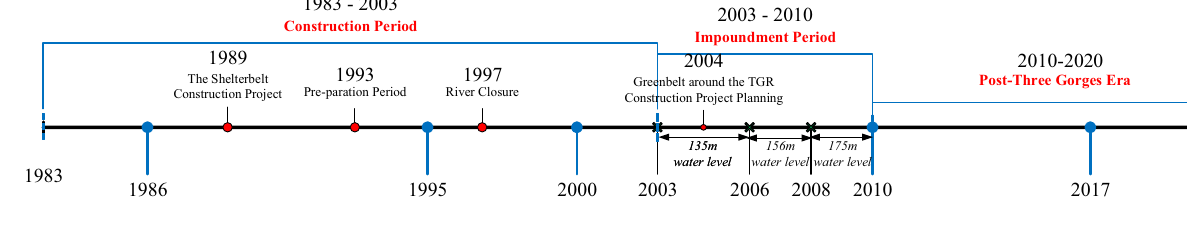
Figure 1. Construction timeline of the TGP.